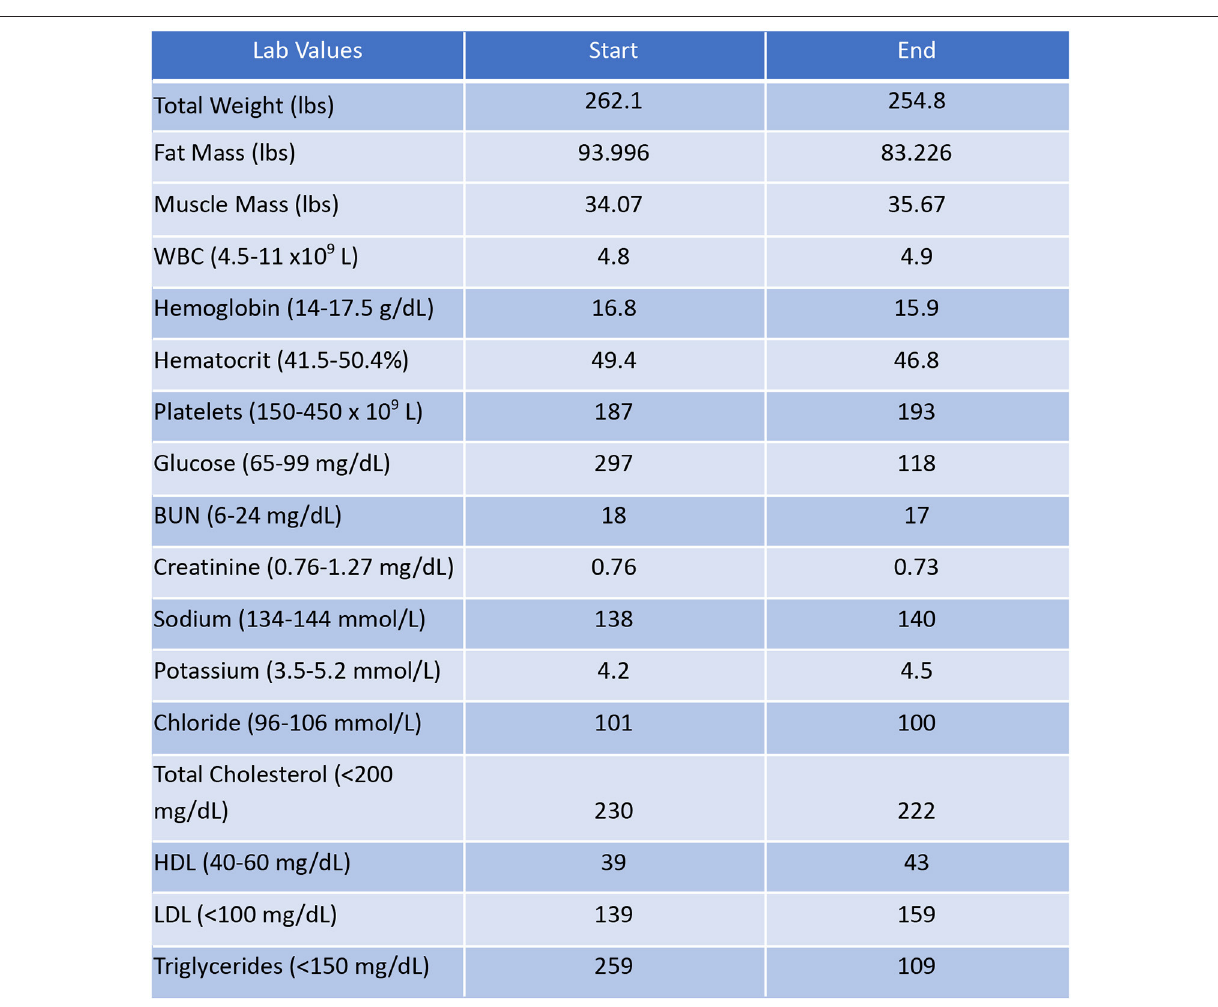
Frontiers in Nutrition |